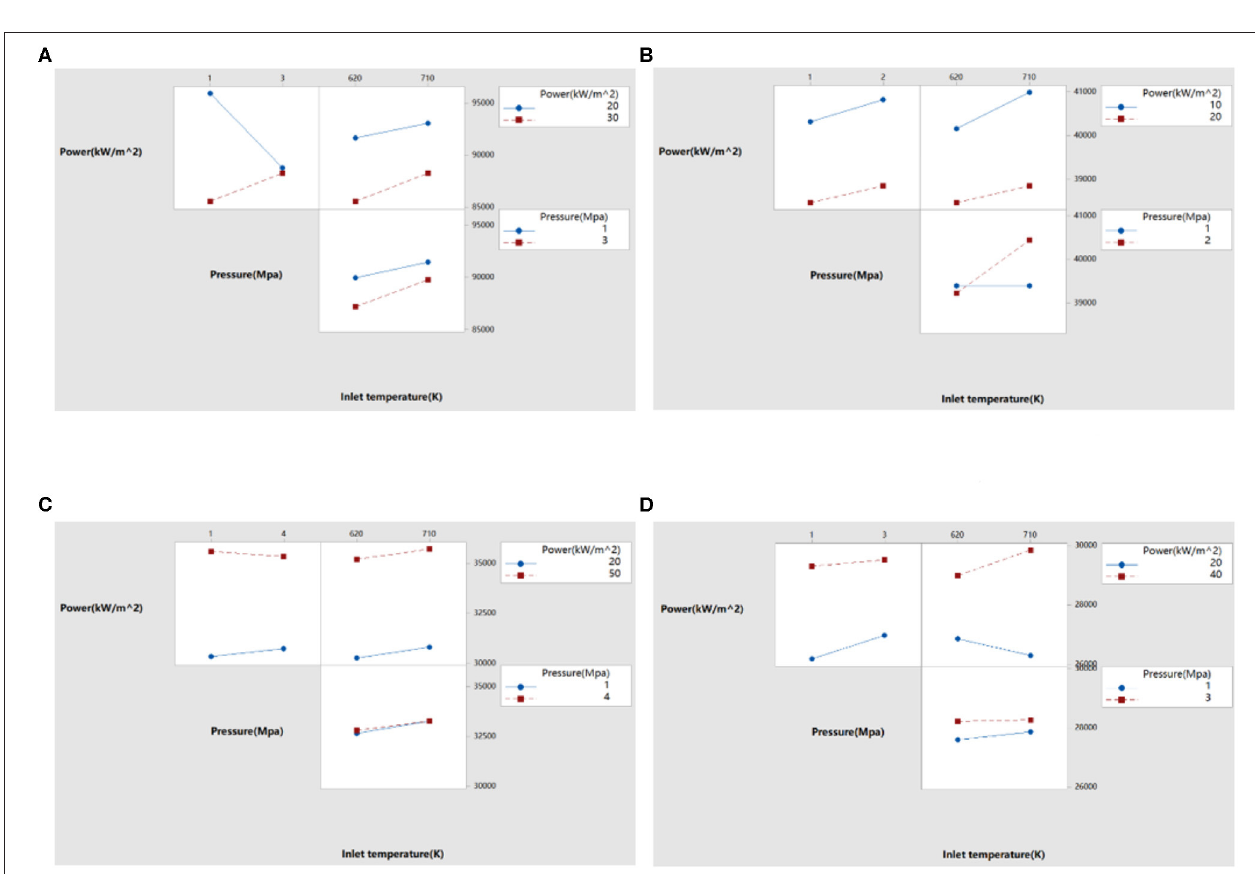
FIGURE 11 | Effect of interaction on heat transfer coefficients of different liquid metals. (A) Effect on heat transfer coefficient of sodium, (B) effect on heat transfer coefficient of sodium-potassium alloy, (C) effect on heat transfer coefficient of lead, and (D) effect on heat transfer coefficient of